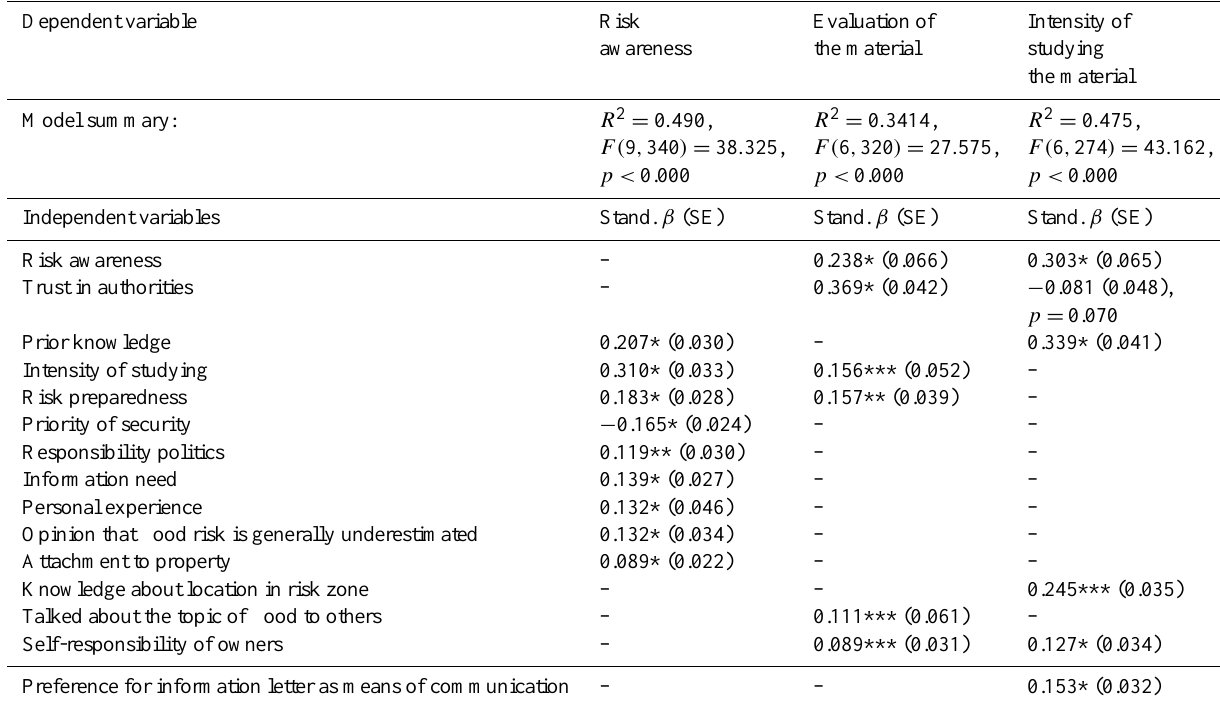
Table 5. Regression on two major predictors of preparedness (awareness & evaluation), and the major predictor of awareness (intensity of studying the